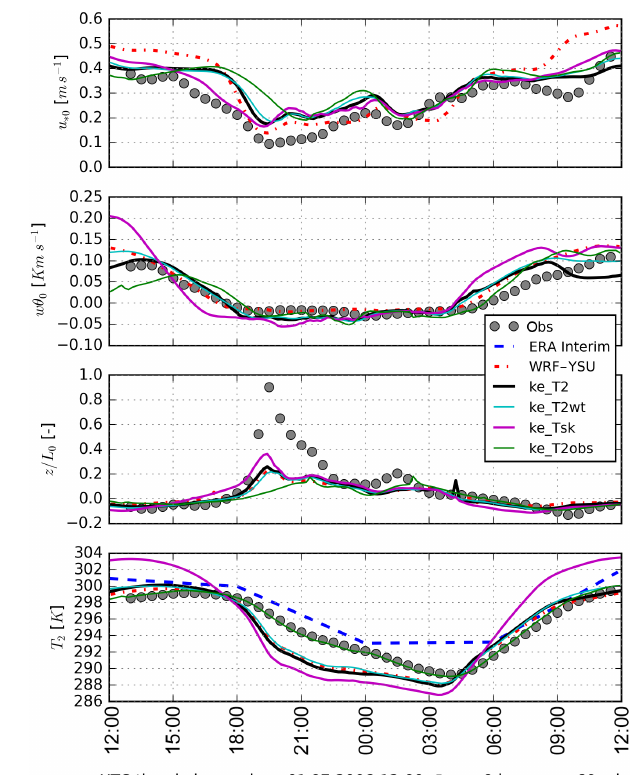
Figure 11. Time series of surface-layer characteristics using differ- ent surface boundary conditions for potential temperature with the k - ε model and compared with ERA Interim input data, mesoscale model simulation and